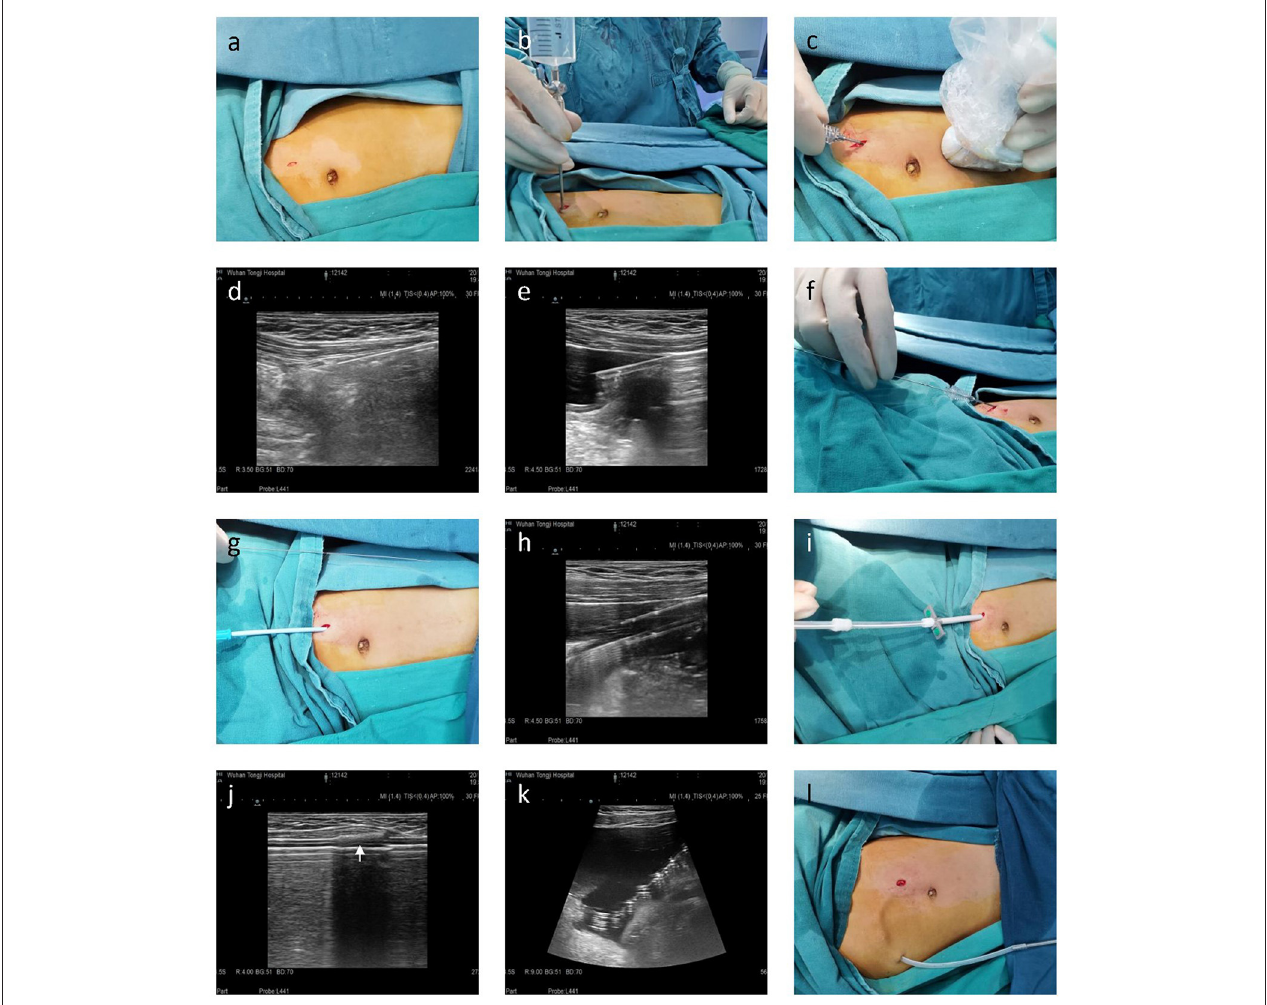
FIGURE 1 | Seldinger placement of a Tenckhoff catheter in a representative pediatric patient in preparation for peritoneal dialysis. (a) A 1cm linear incision was made, and subcutaneous tissue was blunt separated to reach the anterior sheath of the rectus abdominis. (b) A hydroperitoneum was established using a Veress needle. (c–e) A 18-gauge coaxial biopsy needle was advanced in a caudal direction toward the pelvis at 30–45 ◦ from the skin surface using ultrasound guidance. (f) A 0.035-inch guide wire was inserted through the coaxial biopsy needle and directed toward the pelvis. (g,h) 8-French, 12-French, and 14-French introducer